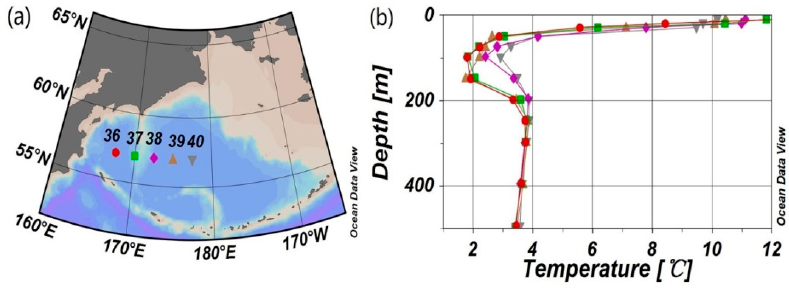
Figure 9. ( a ) The stations from an east-to-west section at 57°N in the Bering Sea basin in August 2004; ( b ) Ttemperature profiles of all stations.